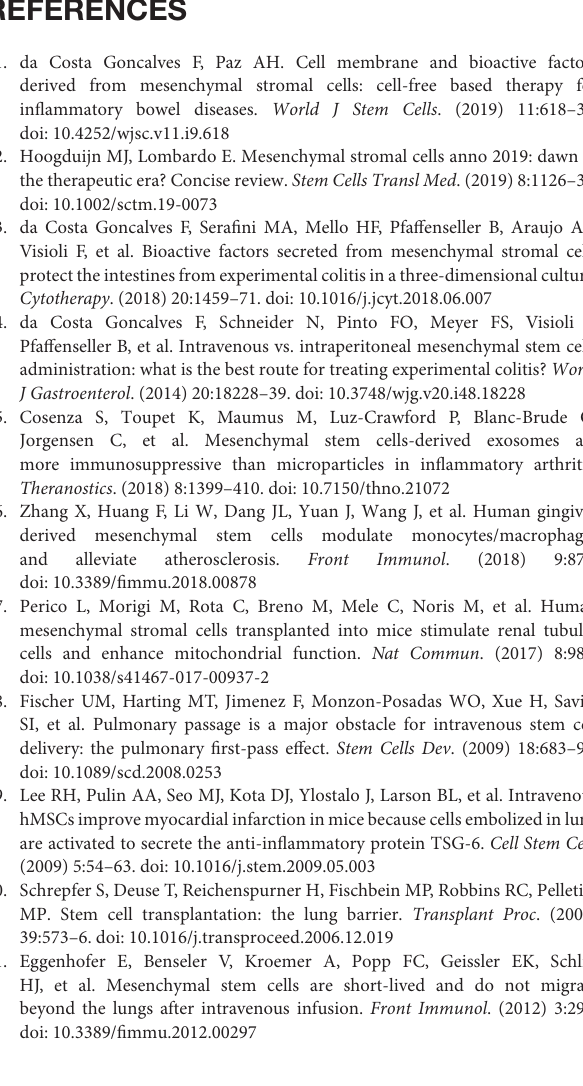
measured by flow cytometer after 6h using 7-AAD. Percentage of macrophage (A) and HUVEC (B) viability. ∗ P < 0.05 and ∗∗∗ P < 0.001 vs. vehicle. Supplementary Figure 3 | Macrophage profile under different culture conditions. Macrophages were primed with 20ng/ml IFN γ and 100ng/ml LPS (inflammatory condition), or 20ng/ml IL-4 and 20ng/ml IL-13 (anti-inflammatory condition). (A) Photomicrographs showing characteristic morphologies of macrophages exposed to different culture conditions for 24h (Magnification 100x). (B) mRNA expression of macrophages by real-time RT-PCR for CXCL10, CCR7, IL-1 β , IL-10, TNF α , TGF β , CCL22, and CD209 after treated with IFN γ + LPS or IL-4 + IL-13 for 72h. Data are presented as mean ± SD from 6 experiments. ∗ P < 0.05 , ∗∗ P < 0.01 , and ∗∗∗ P < 0.001 vs. medium control. Supplementary Figure 4 | HUVEC profile under different culture conditions. HUVEC were primed with single or combined doses of 10ng/ml TNF α and 50ng/ml IFN γ and assessed by flow cytometer and real-time RT-PCR. (A) Photographs showing characteristic morphologies of HUVEC exposed to different culture conditions for 24h (Magnification 100 × ). (B) HUVEC surface levels of HLA-I, HLA-II, CD40, and CD144 and (C) mRNA expression of HUVEC for IL-6, IL-8, and endothelin in the presence of single or combined doses of TNF α and IFN γ after 72h. Data are presented as mean ± SD from 6 experiments. ∗ P < 0.05 , ∗∗ P < 0.01 , and ∗∗∗ P < 0.001 vs. medium